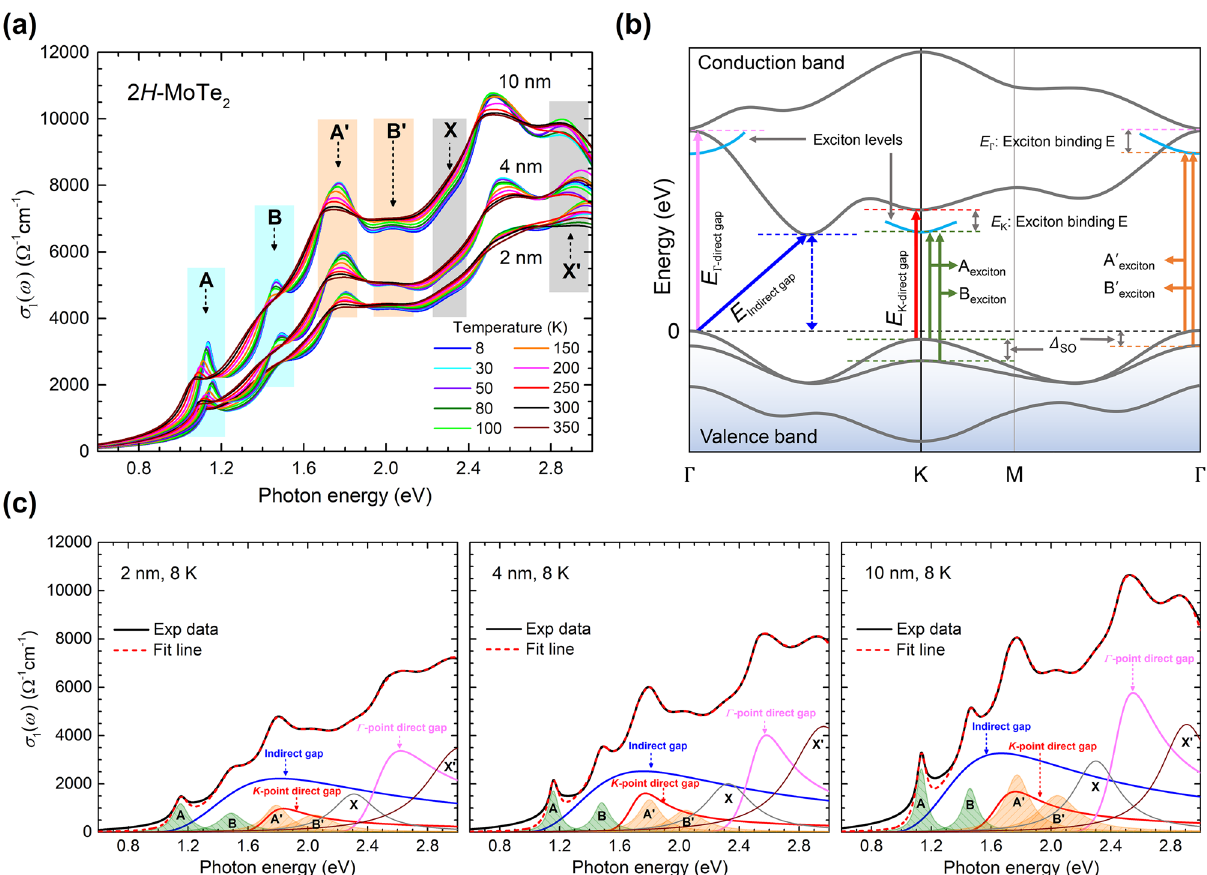
Figure 2. Analysis of real part of optical conductivity and optical designation in band structure of TMDs. ( a ) Real part of optical conductivities for 2, 4, and 10 nm thick 2H-MoTe 2 at various temperatures between 8 and 350 K. ( b ) Schematic of band structure of multilayered TMDs with optical designations. ( c ) Real part of optical conductivities fitted using Lorentz and TL models at 8